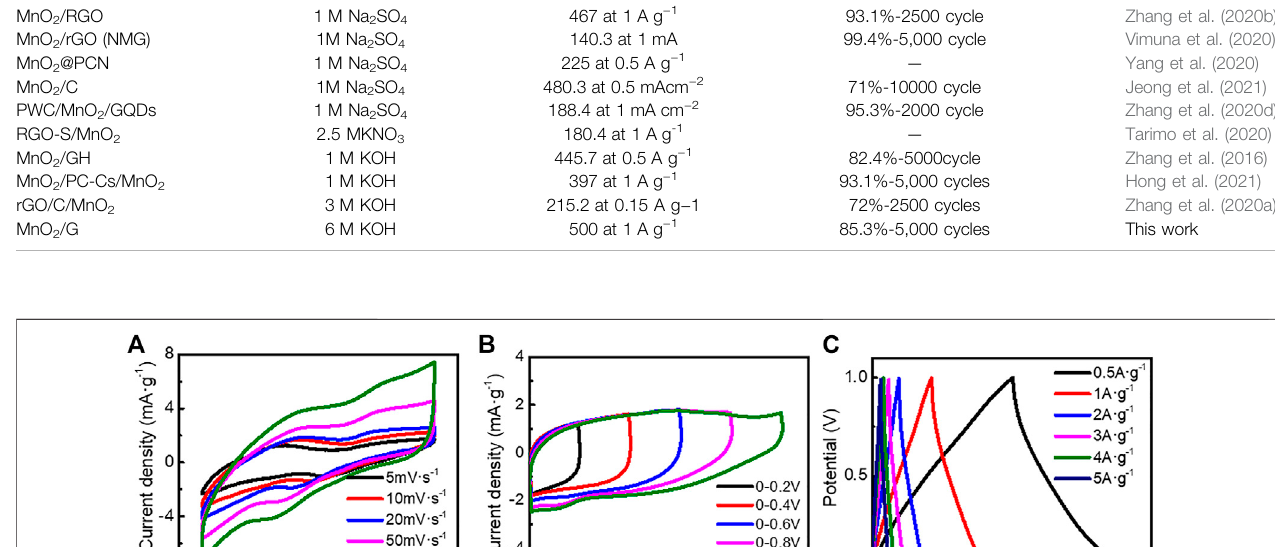
TABLE 1 | Summary of the electrochemical performance of existing C/MnO2 composites. Electrode materials